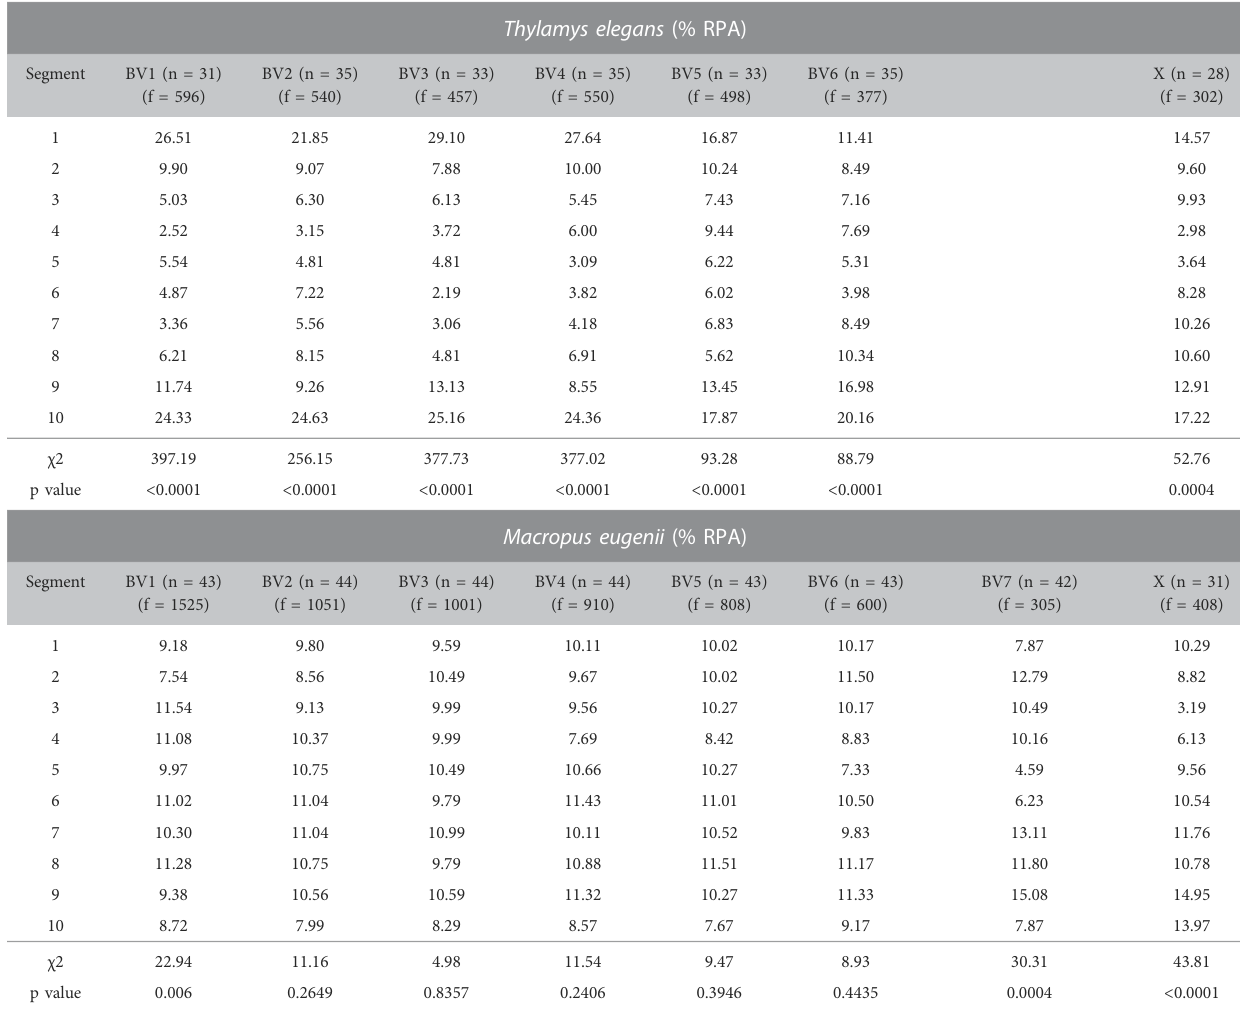
TABLE 1 Percentage of RPA foci per chromosomal segment in the different bivalents (BV) and the X chromosome (X) of Thylamys elegans and Macropus eugenii . A χ 2 of goodness of fi t test (9 degrees of freedom) was performed to assess the deviation from a random distribution along chromosomes. Signi fi cance was considered when p ≤ 0.05. n: number of bivalents analyzed; f = number of